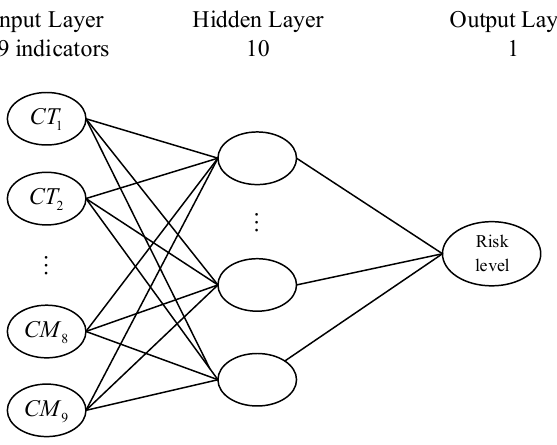
Figure 1. BP neural network operation structure.